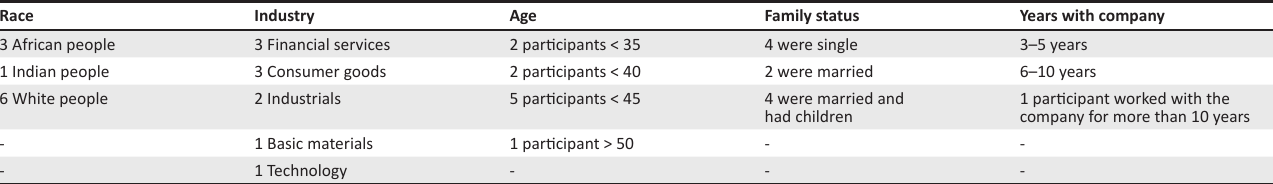
TABLE 1: Demographic representation of